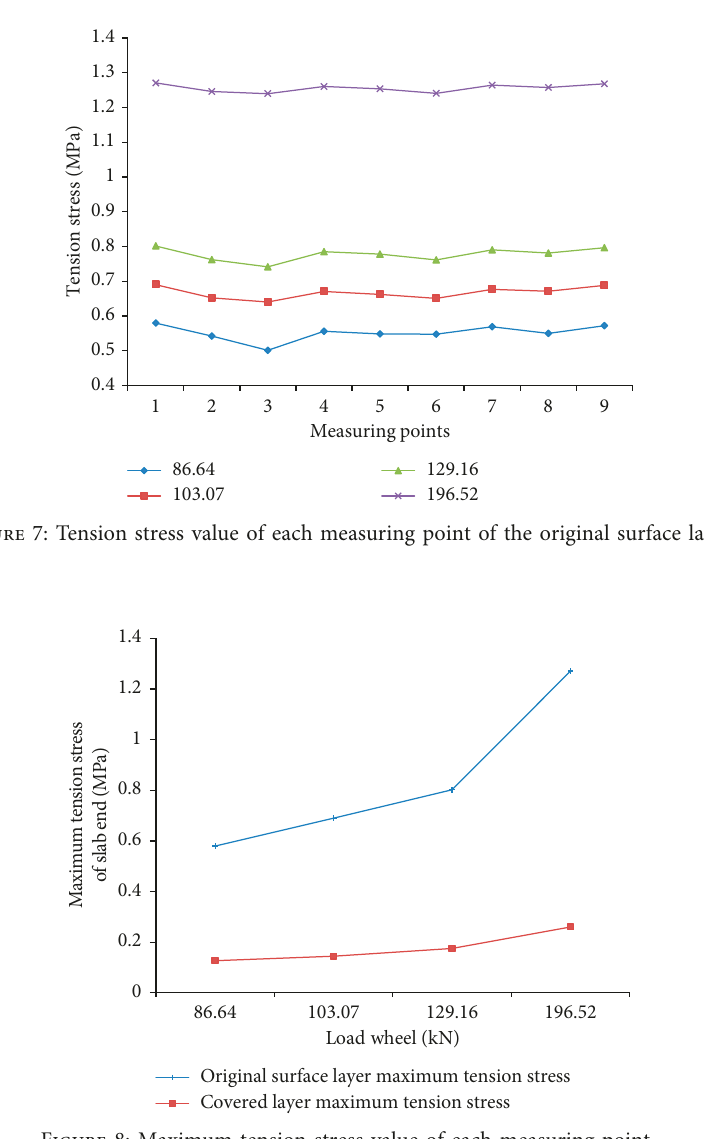
Figure 8: Maximum tension stress value of each measuring point.